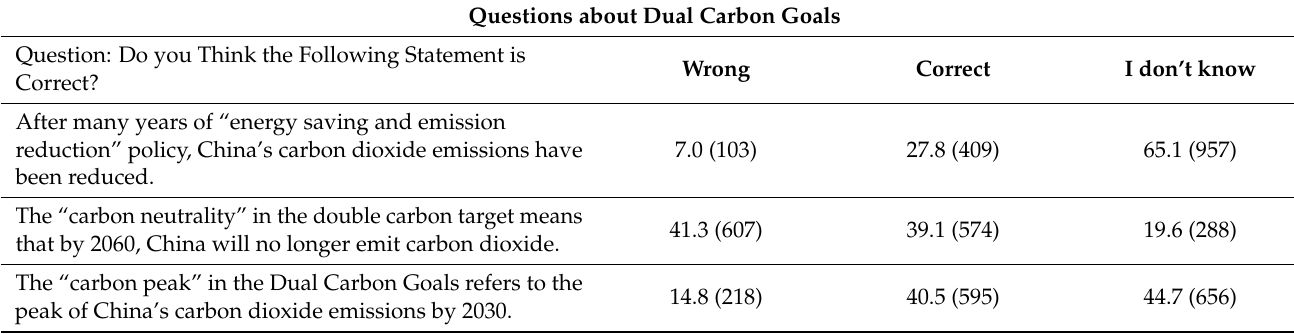
Table 5. Participants’ knowledge about the Dual Carbon Goals ( n =